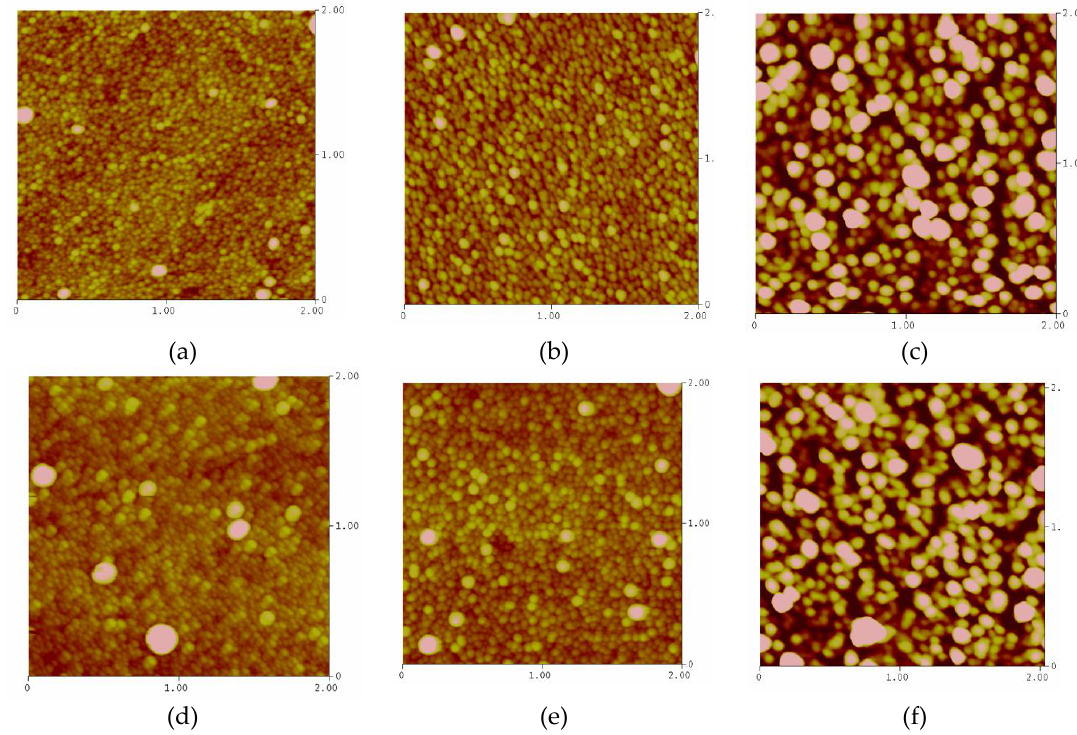
Figure 4. AFM scans of AuNPs electrodeposited with ( a ) method 1, ( b ) method 2, ( c ) method 3 and protein of ( d ) BSA, ( e ) GOx and ( f ) casein coated AuNPs. The AFM scans area were 2 μ m × 2 μ m and the color scale of the scan range from 0 – 125 nm.